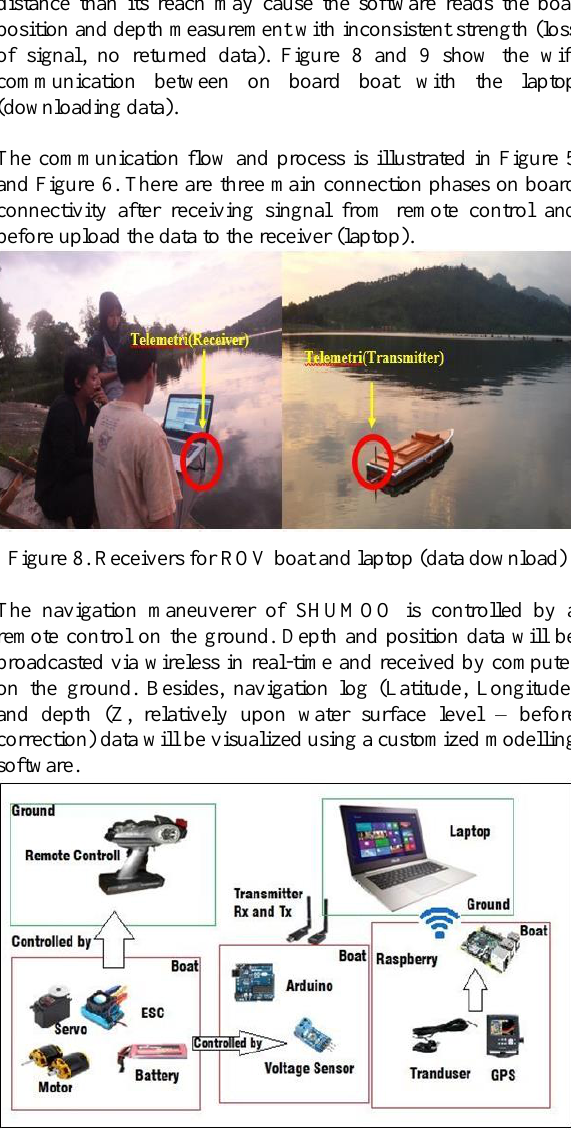
Figure 9. Example of major components and the communication architecture (Suhari,